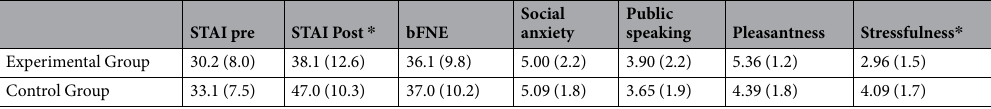
Table 1. Average (s.d.) scores on each questionnaire in the Experimental and Control groups. * p <